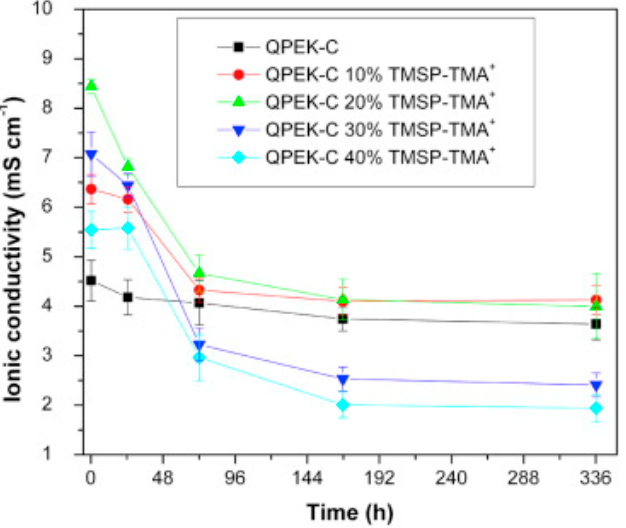
Figure 11. Effect of exposure to (1.5 M VO 2+ + 3 M H 2 SO 4 ) at 30 °C on sulfate ion conductivity of